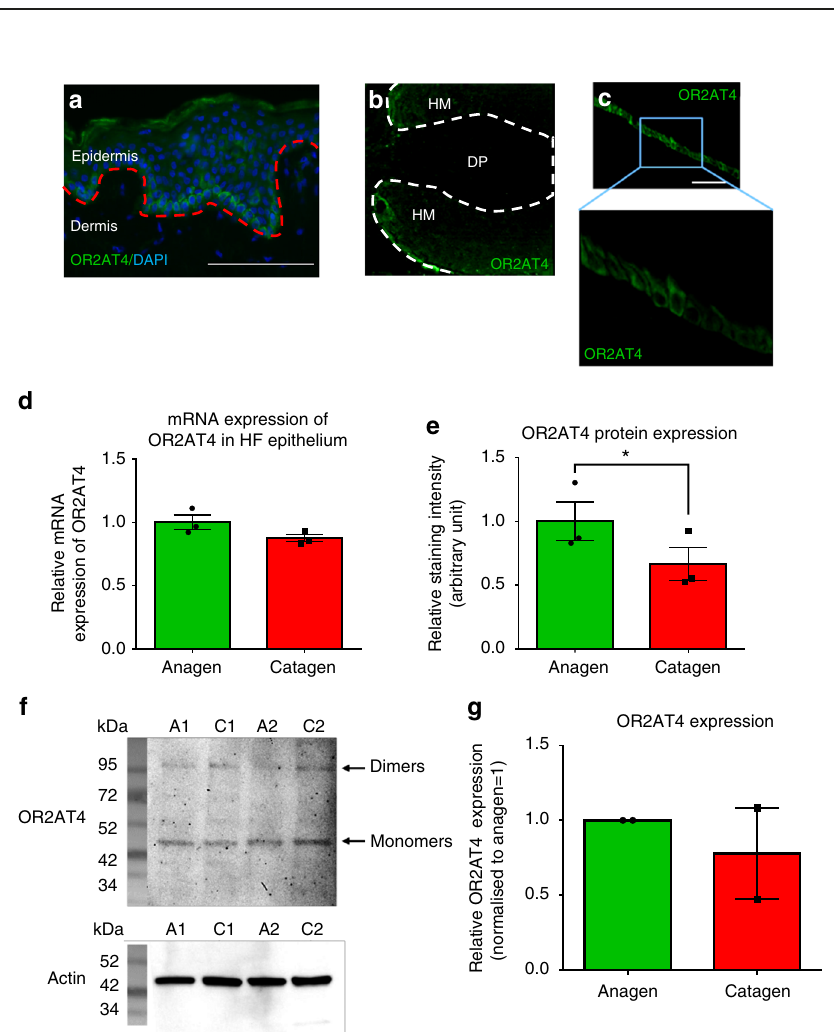
Fig. 2 OR2AT4 mRNA and protein expression in human scalp epidermis and hair follicles in situ. a Representative pictures of OR2AT4 immuno fl uorescence in human scalp epidermis of three different donors (positive control 20 ). Red line delineates the dermo-epidermal basement membrane. Cytosolic expression of OR2AT4 in hair matrix and suprabulbar outer root sheath (ORS) keratinocytes. Scale bar: 100 µ m. b , c Representative pictures of confocal imaging of OR2AT4 immuno fl uorescence in human scalp HFs from three different donors (independent experiments). Scale bar: 100 µ m. d , e mRNA (normalized against GAPDH) and in situ protein expression of OR2AT4 in anagen and catagen microdissected HF epithelium. Mean ± SEM, n = 3 from nine HFs/donor from three donors (independent experiments), Student ’ s t -test, * P < 0.05. f , g Western blot analysis and quantitative results of OR2AT4 (normalized against actin) in anagen and catagen microdissected human scalp HFs. Mean ± SEM from nine HFs/donor from two donors (independent experiments). The speci fi c band for OR2AT4 is found around 44 kDa, although the predicted molecular weight of OR2AT4 is 36 kDa. This slight difference can be explained by a post-translational modi fi cation (an acetylation site has been identi fi ed on the lysine at the position 303 [source: phosphoSitePlus ® ]) that would increase the molecular weight 64 . A1-2 indicates anagen HFs and C1-2 indicates catagen HFs from donor 1 and 2. DP dermal papilla, HM hair